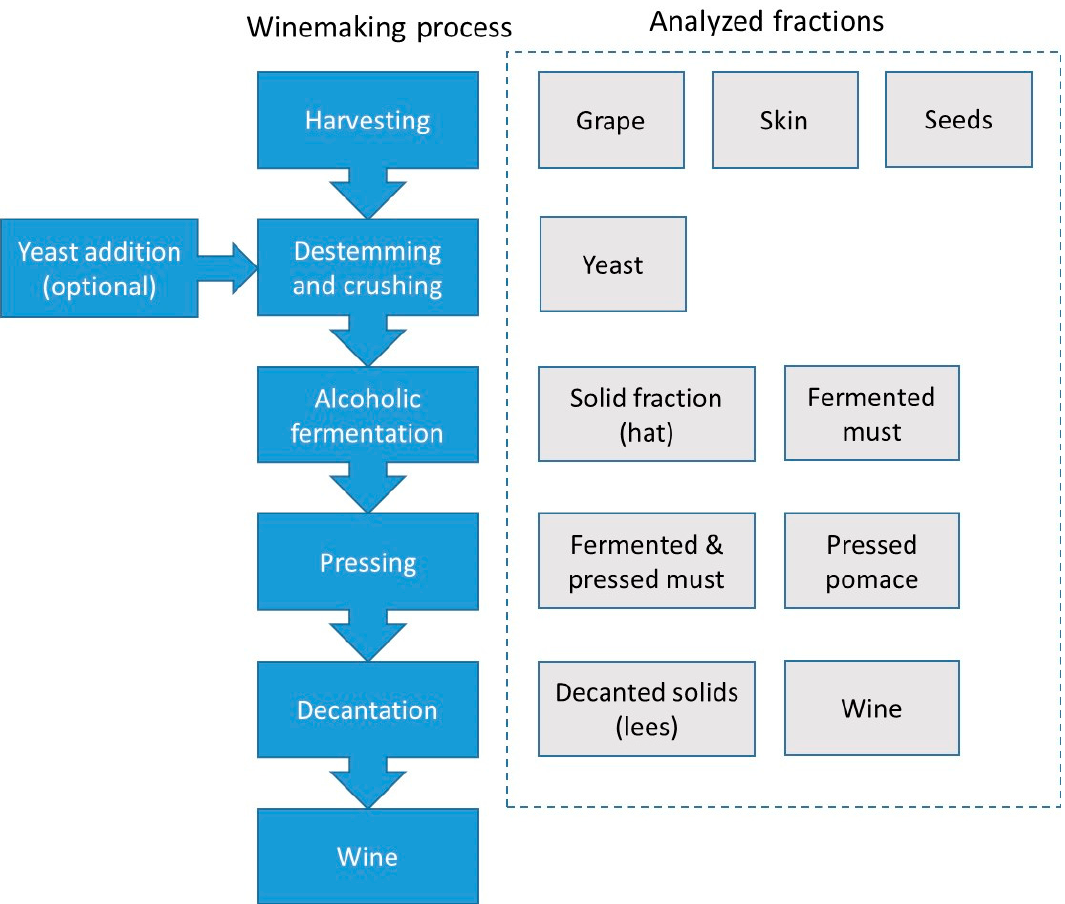
Figure 4. Scheme of the winemaking process (blue boxes) and analyzed fractions (grey boxes).